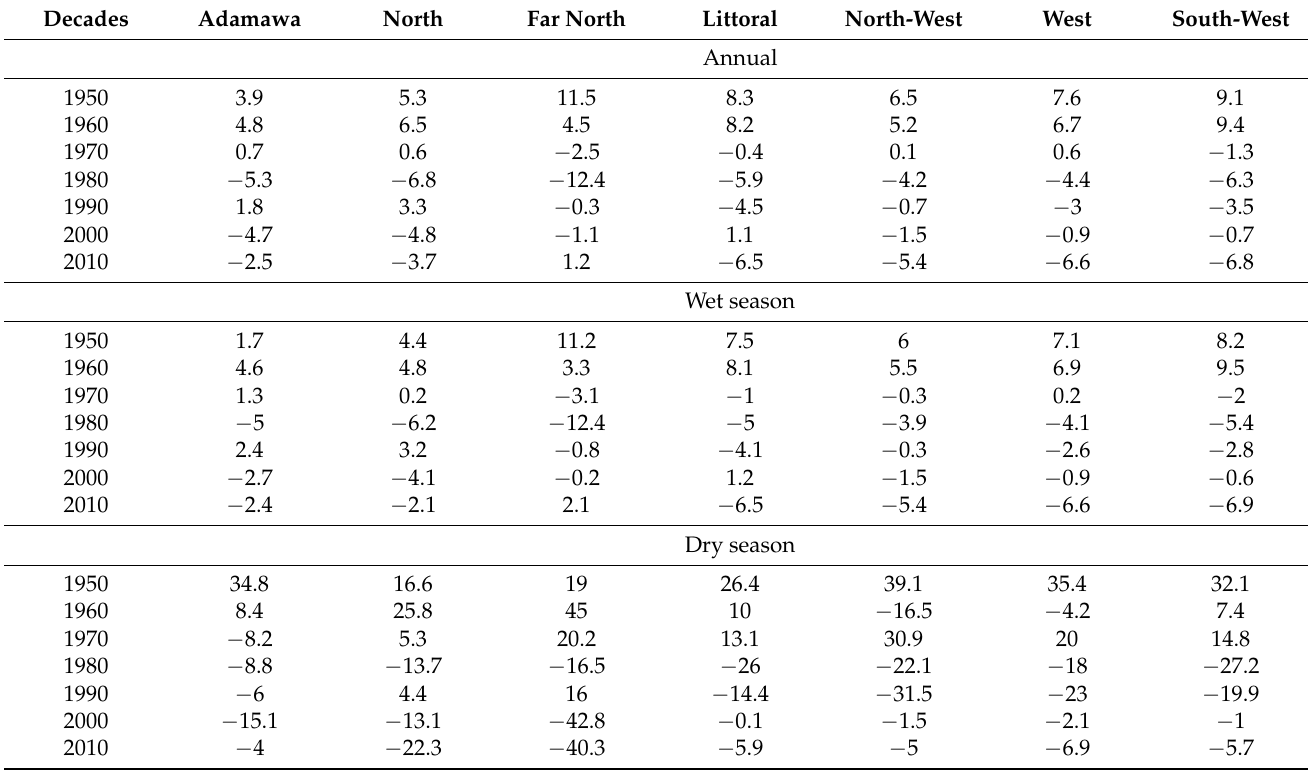
Table 3. Deviations (%) of the decadal annual and seasonal averages of rainfall compared to their interannual means for the northern regions (Adamawa, North, and Far North) and western regions (Littoral, North-West, West, and South-West) of the